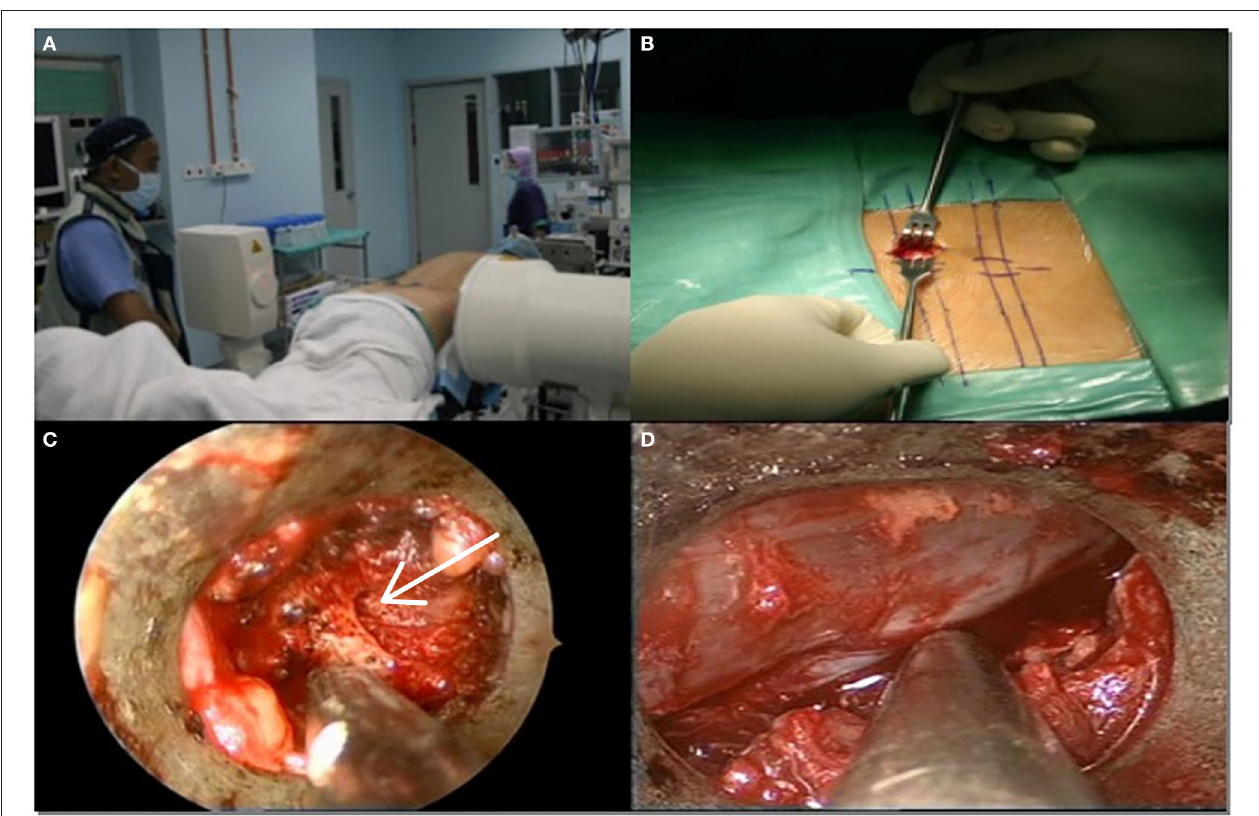
FIGURE 1 | (A) Positioning and level marking. (B) Incision length was about 23mm. (C) Spinolaminar junction was identified (white arrow). (D) Decompression was completed after traversing nerve root fully